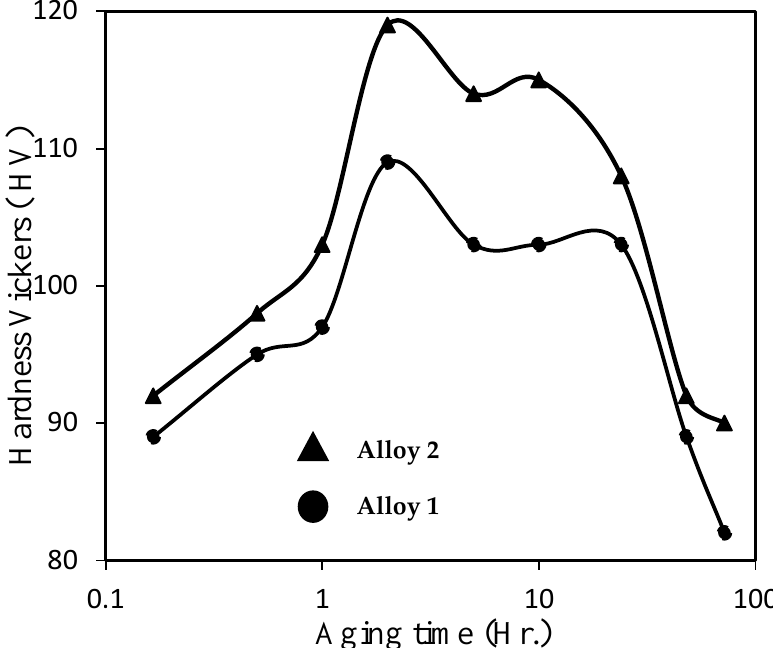
Figure 5. Aging curves of as-cast Alloy 1 and Alloy 2, showing HV10 vs. aging time after the ageing heat-treatment process.